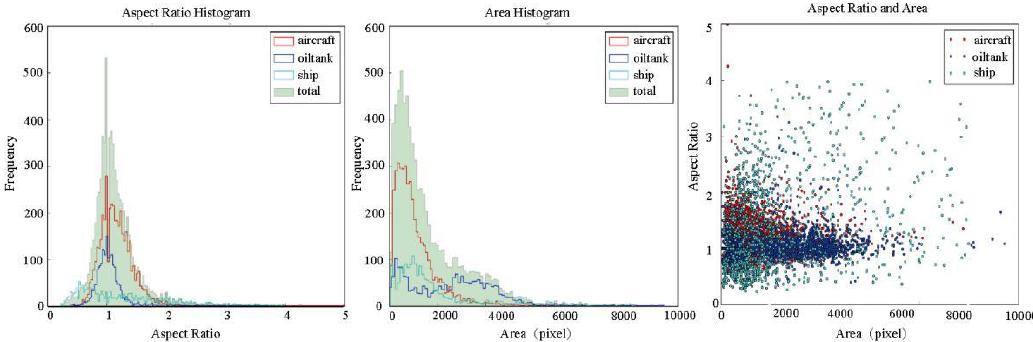
Figure 6. The histograms of the distribution of the area size and aspect ratio of the bounding boxes.